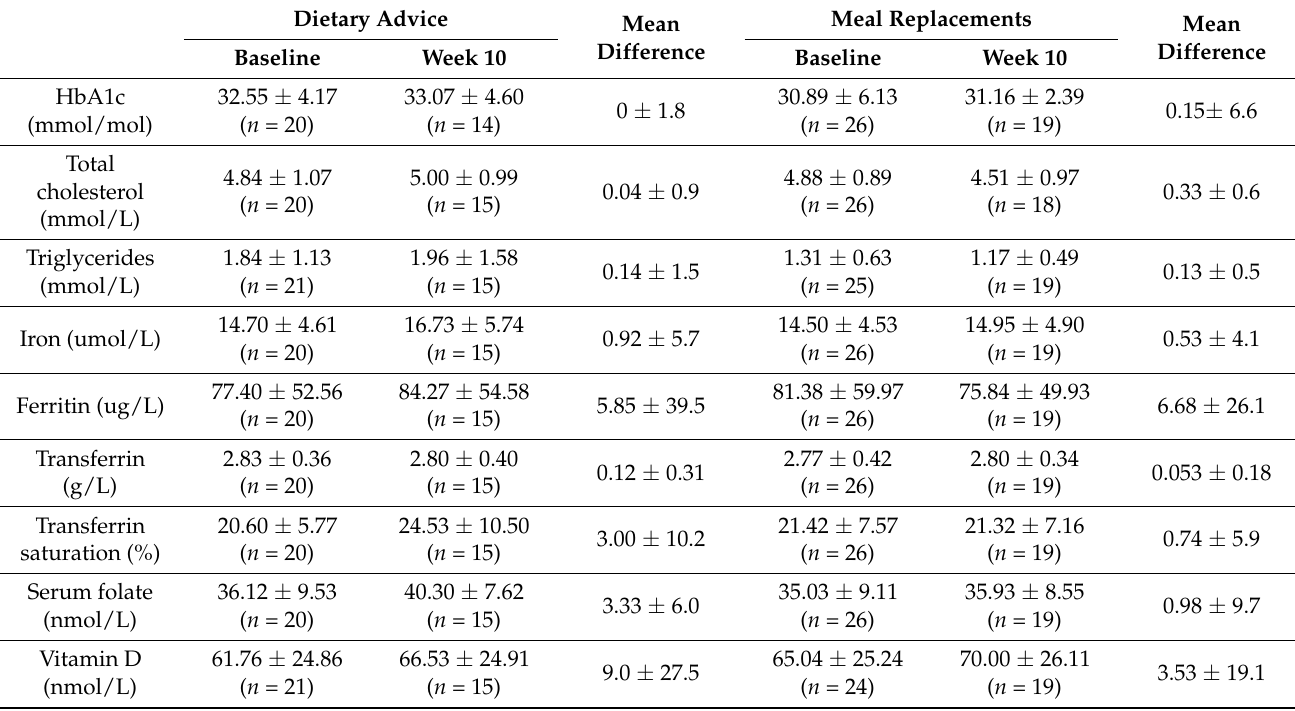
Nutritional status (iron status, serum folate or vitamin D improved on both programs with no differences between the groups (Table 4). Table 4. Changes in blood chemistry status in the Dietary Advice and Meal Replacement groups before and after the 10-week